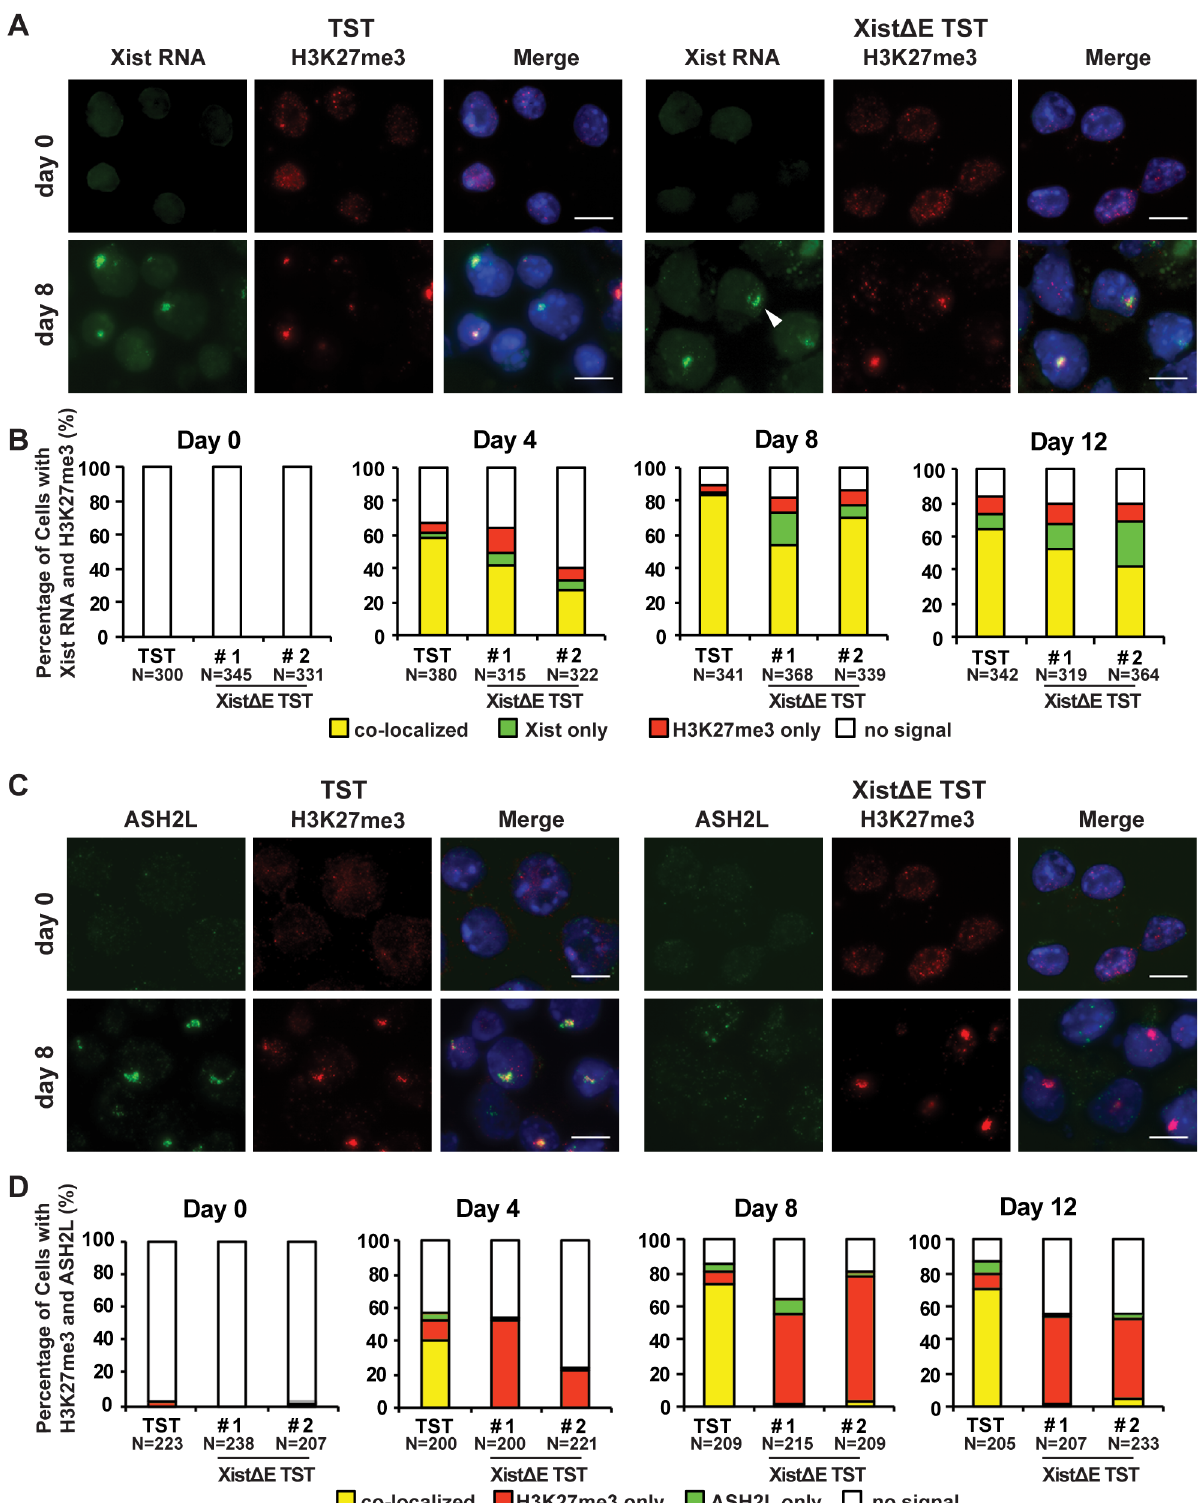
Fig 3. The repeat E of Xist RNA is required for the loading of ASH2L to the Xi but not for the deposition of the repressive epigenetic modifications. (A) Immuno-FISH for Xist RNA (green)and H3K27me3(red) at day 0 and 8 upon differentiation. Nuclei were